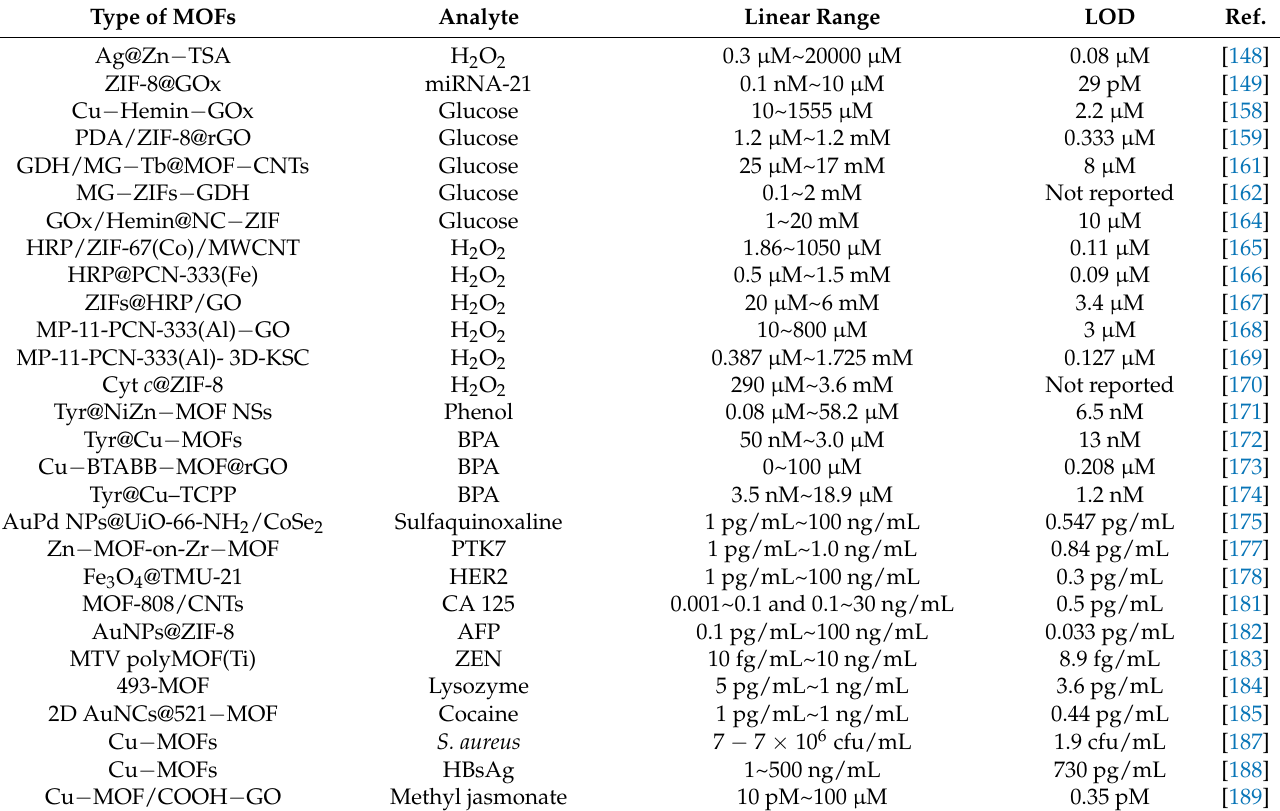
Table 5. Detection performances of different electrochemical sensors using MOFs as support platforms. Type of MOFs